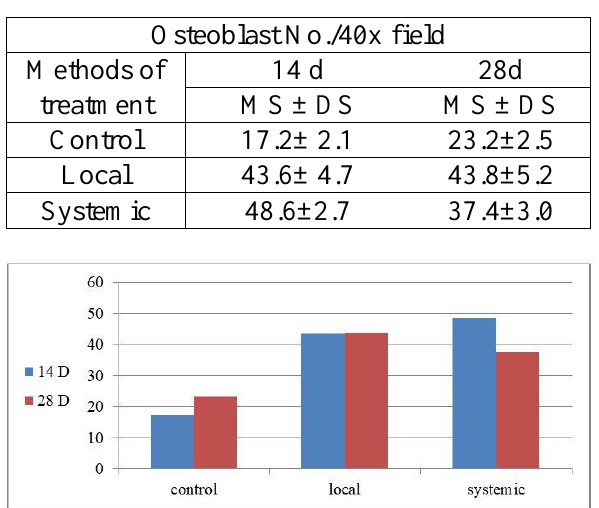
Fig.3: The histogram of statistical analysis of the number of osteoblasts founded.